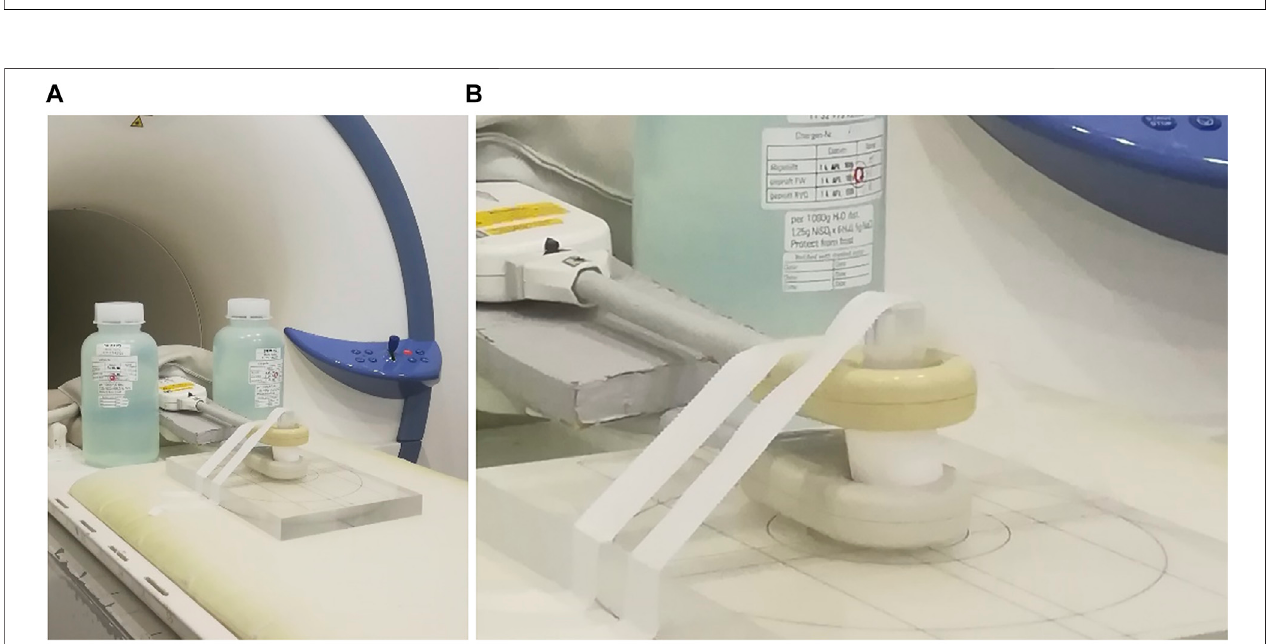
FIGURE 6 | (A) The INFINITY 6 MV ELEKTA accelerator with the standard electron cone in position. (B) A close-up picture showing the irradiation setup for the 6 MeV electron beam, the 6 × 6 irradiation fi eld and the phantom gel vial. Electron irradiation beam entering from top to bottom of the vial.